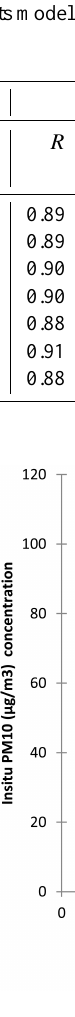
10 measurement and monthly predicted PM 10 from three independent monitoring